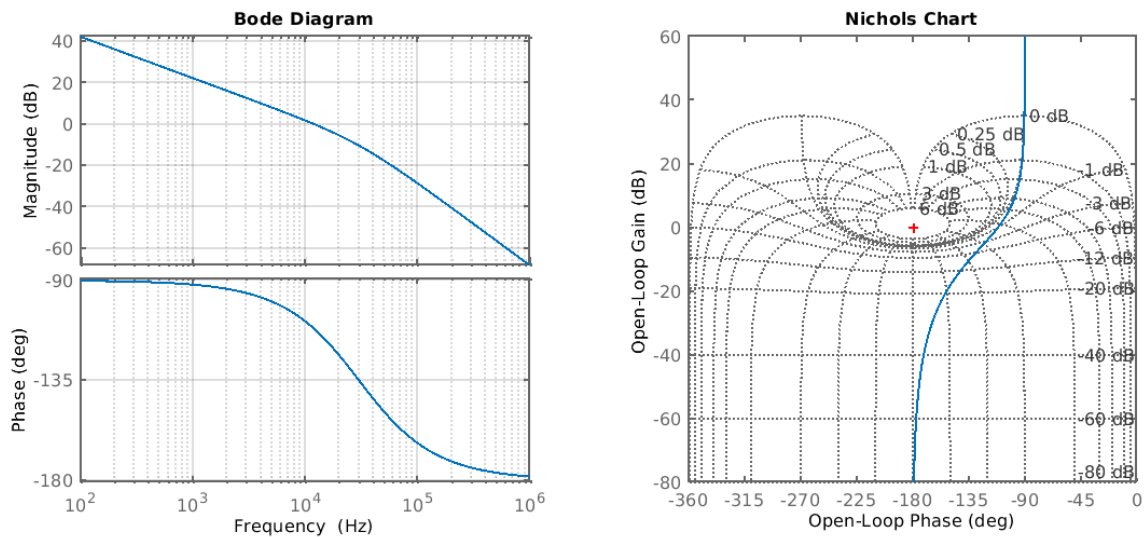
Figure 10. The left plot shows the Bode plot of the Open Loop Transfer Function of the control of the arm cavity. The Unity Gain Frequency is around 10 kHz. The plot in the right shows the Nichols plot of the same system, and it shows that the control is stable and it is far from the overshoot region (1–6